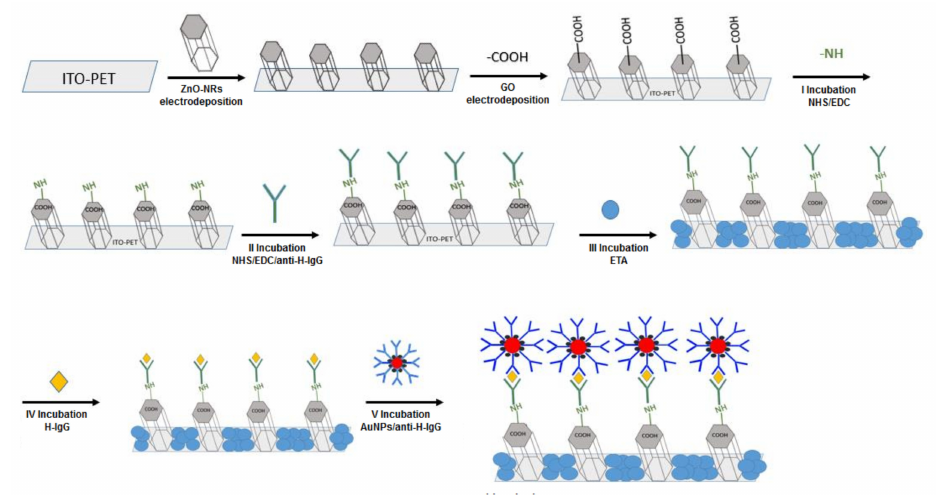
Figure 1. Scheme of the fabrication of immunosensor with a sandwich configuration based on ZnO